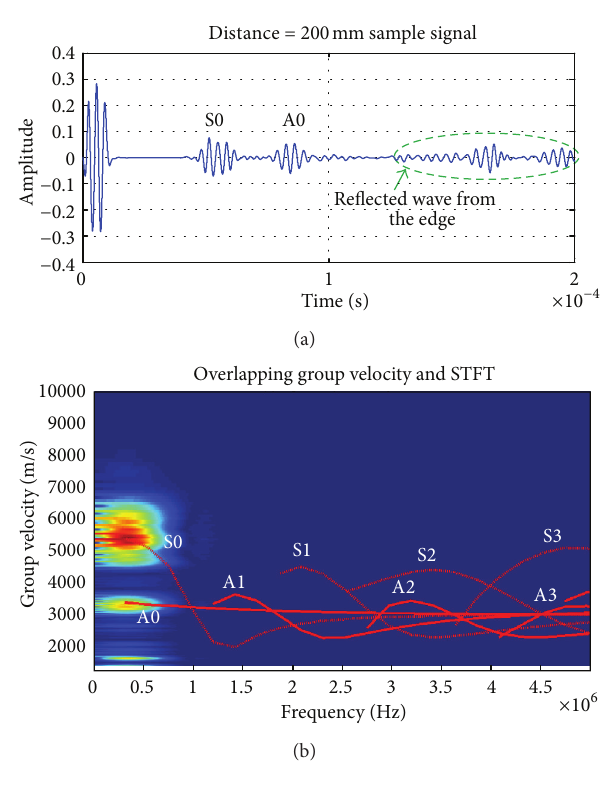
Figure 5: (a) The signal generated and received by MFC patches. (b) Overlapping the group velocity with